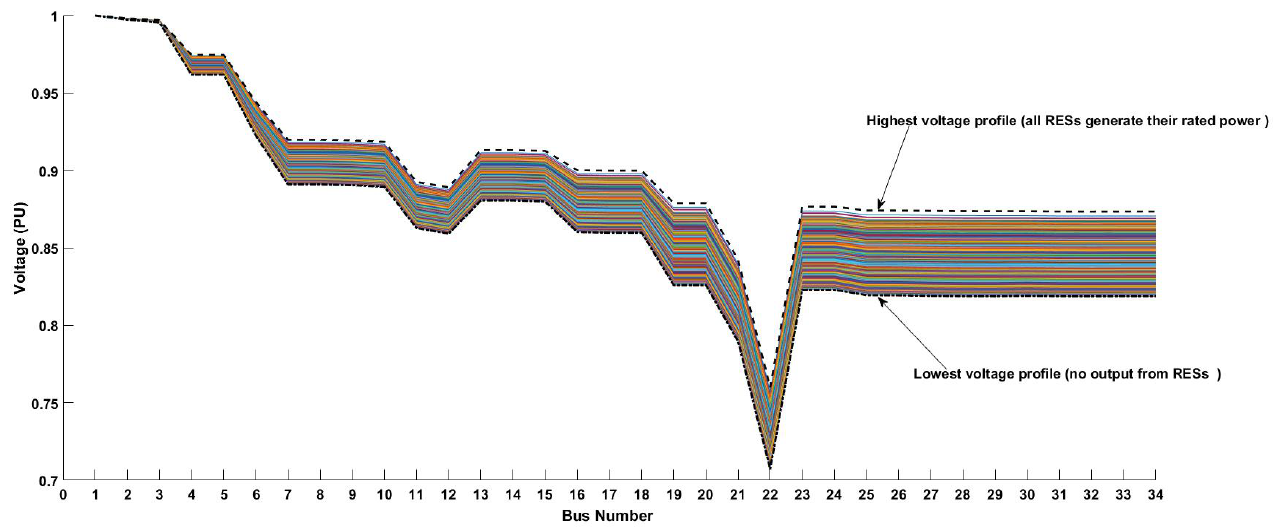
Figure 4. System voltage profiles all over the year for 50% penetration level.